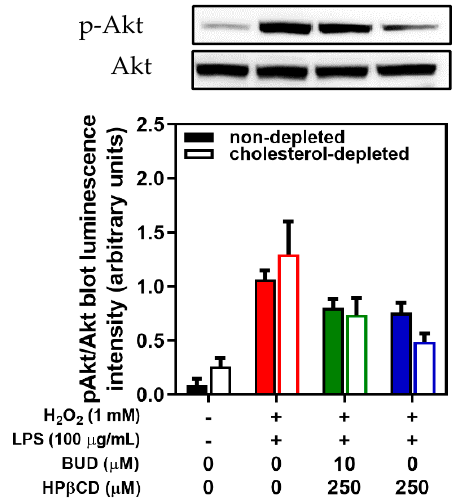
Figure 7. Effect of the BUD:HP β CD complex versus HP β CD on H 2 O 2 + LPS-induced Akt phosphorylation (p-Akt) in cholesterol-depleted and non-depleted A549 cells after 2 h of incubation with representative blot (cholesterol-depleted cells); each bar represents the mean of 3 independent measures.